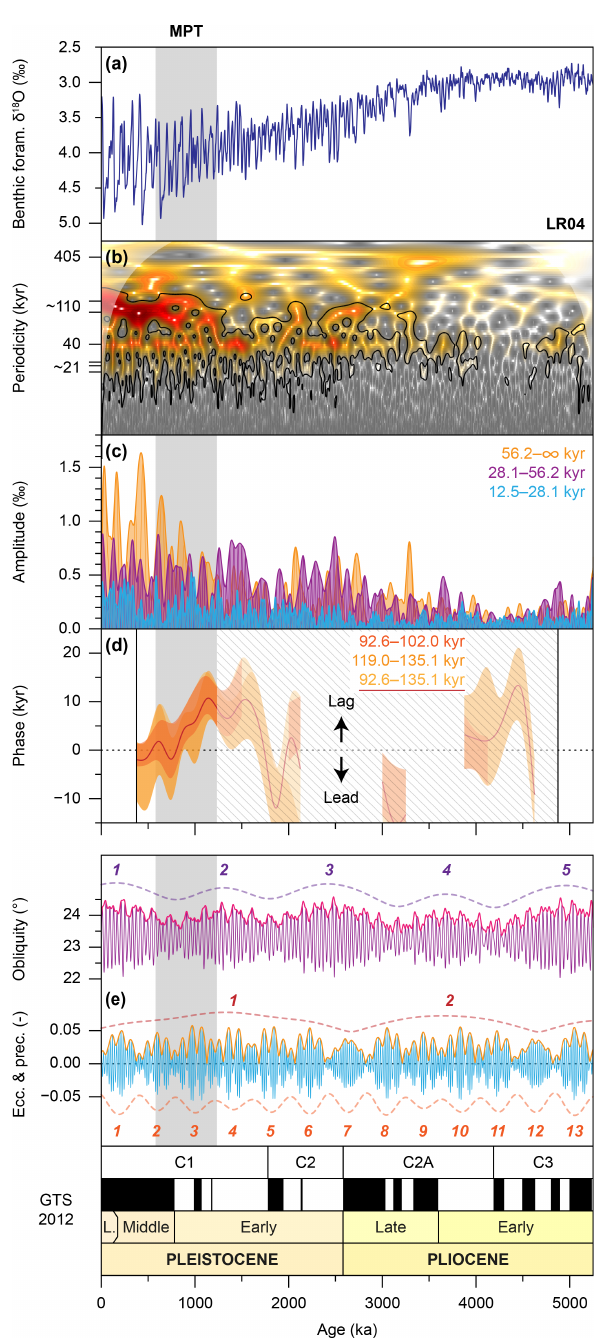
Figure 1. Sinusoidal properties of Pliocene and Pleistocene climate cycles (after Lisiecki and Raymo, 2005a; Lisiecki, 2010). (a) Re- sampled LR04 benthic foraminiferal δ 18 O stack. (b) Wavelet anal- ysis of the LR04 stack after detrending. Black contours represent 95% significance. (c) Absolute amplitude modulations and filters of the ∼ 110, 40, and ∼ 21kyr periodicities. (d) Phase evolution of the ∼ 110kyr periodicity with respect to eccentricity (Laskar et al., 2011a, b), computed over a 750kyr sliding window shown only when coherent (Paillard et al., 1996). (e) Astronomical and magne- tostratigraphic reference records (Hilgen et al.,